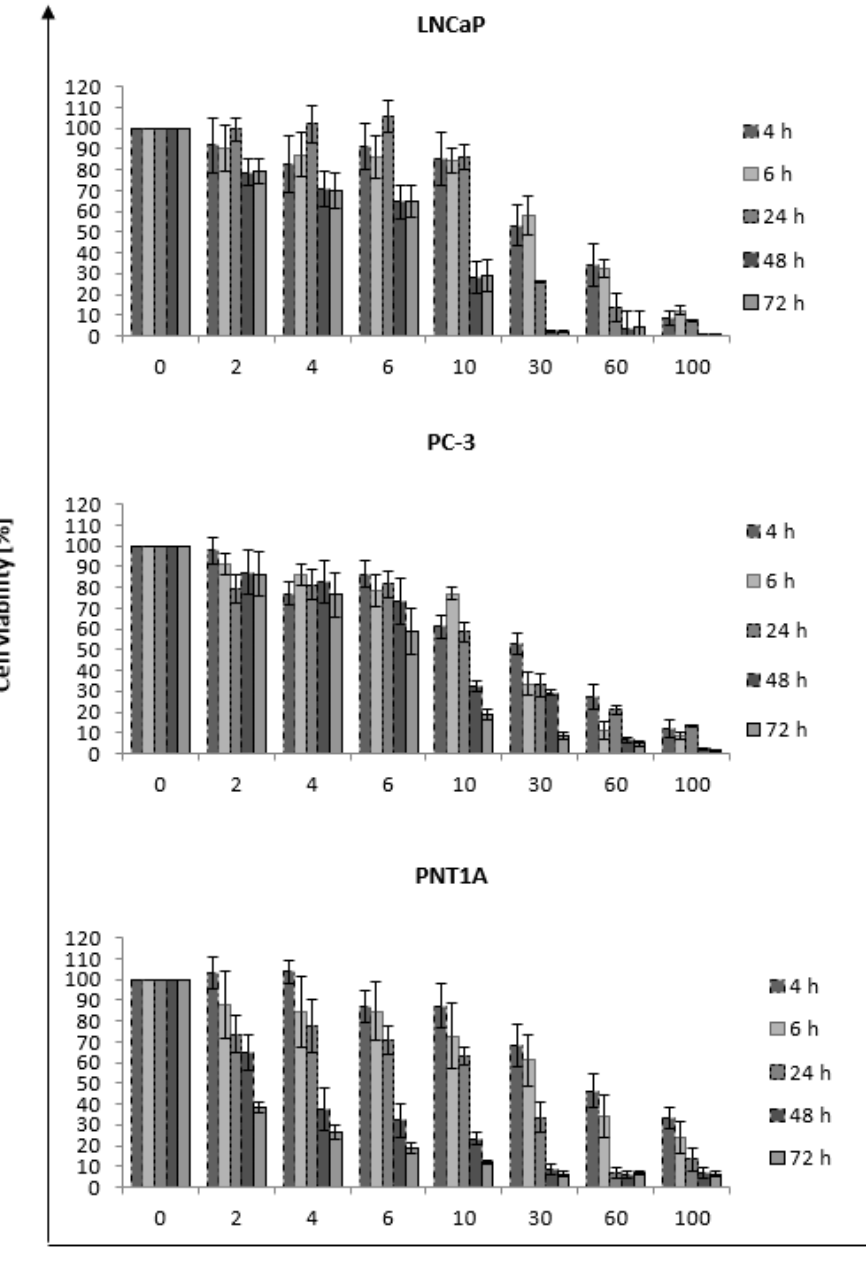
Figure 2. The effect of incubation with gold nanorods on the viability of LNCaP, PC-3, and PNT1A cells. The values presented in the graph are the mean of the obtained results and the deviation is the standard deviation. The experiment was performed in triplicate.